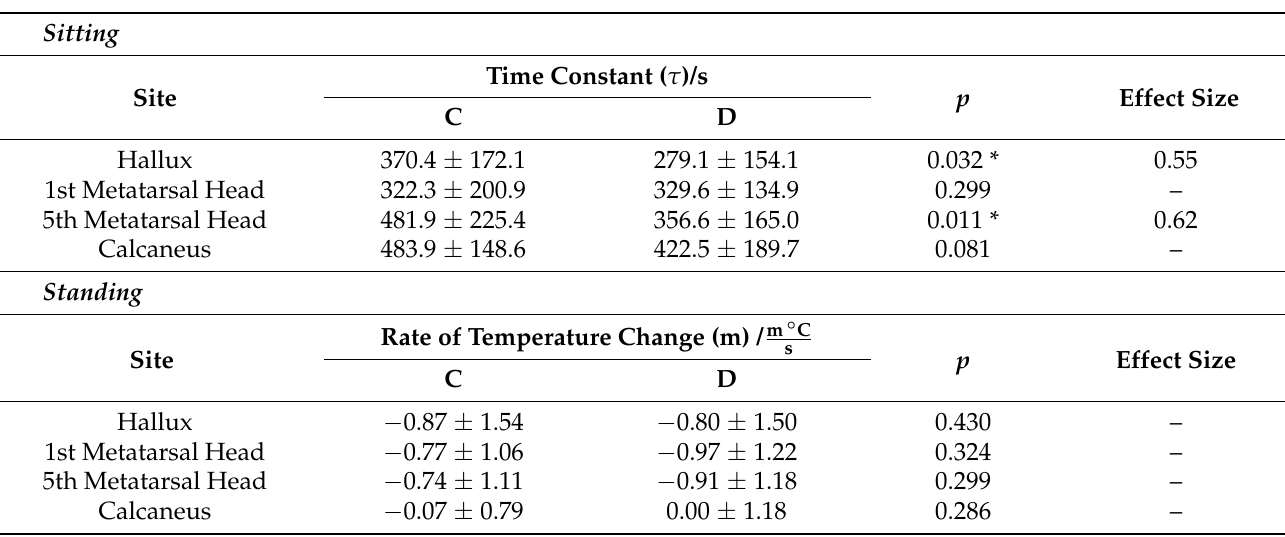
Table 3. Results from the sitting and standing stages. Control group participants (C), participants with diabetes (D). Values are mean ± SD. * p <